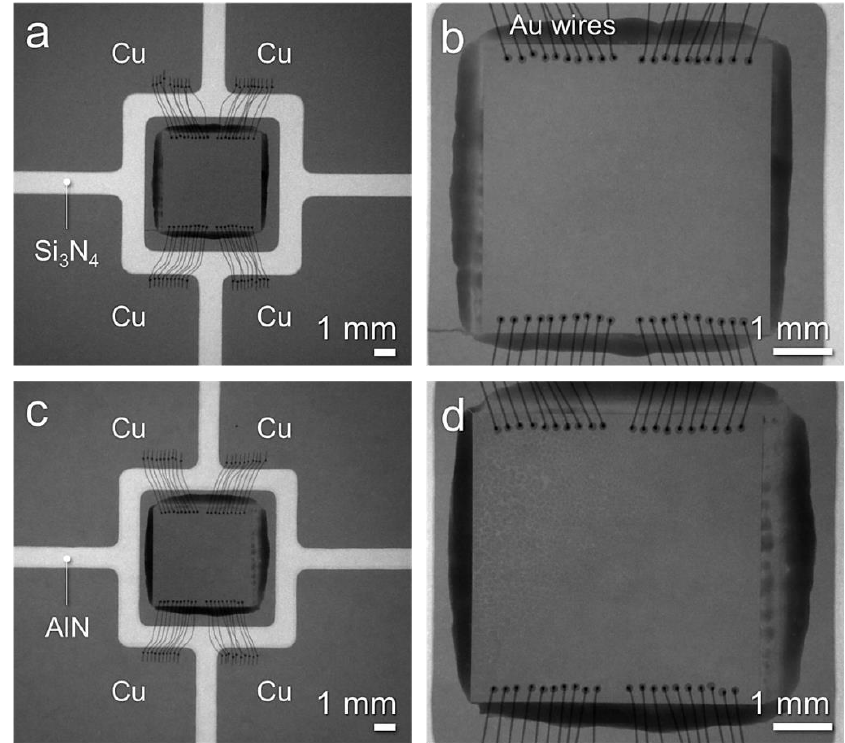
Figure 10. Nondestructive test results (X-ray) after power cycling tests (20,000 cycles): ( a ) specimen of Si 3 N 4 and ( b ) its high magnification image, ( c ) specimen of AlN and ( d ) its high magnification image.